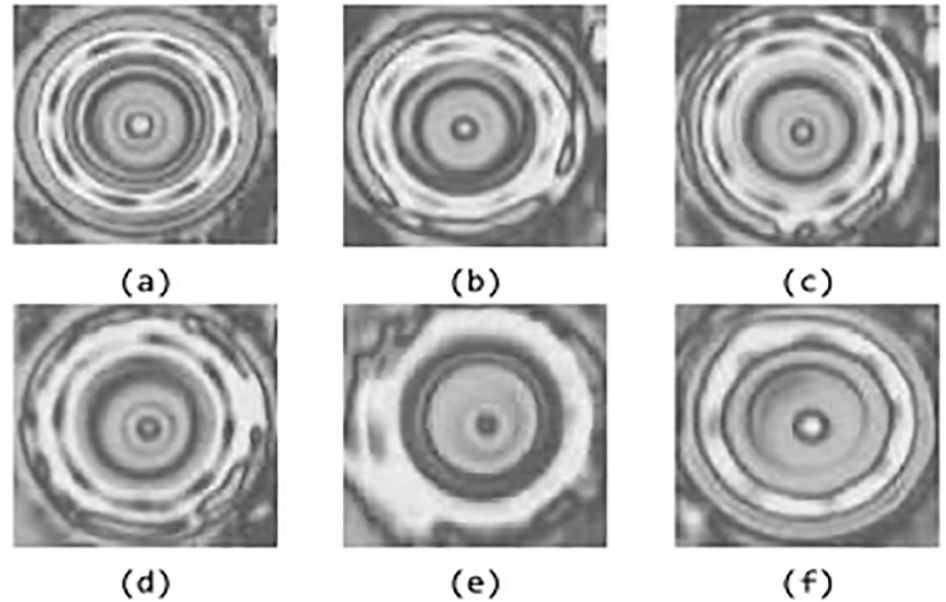
Figure 45. Thermal images results for ( a ) healthy state, ( b ) outer race, ( c ) inner race, ( d ) ball defect,